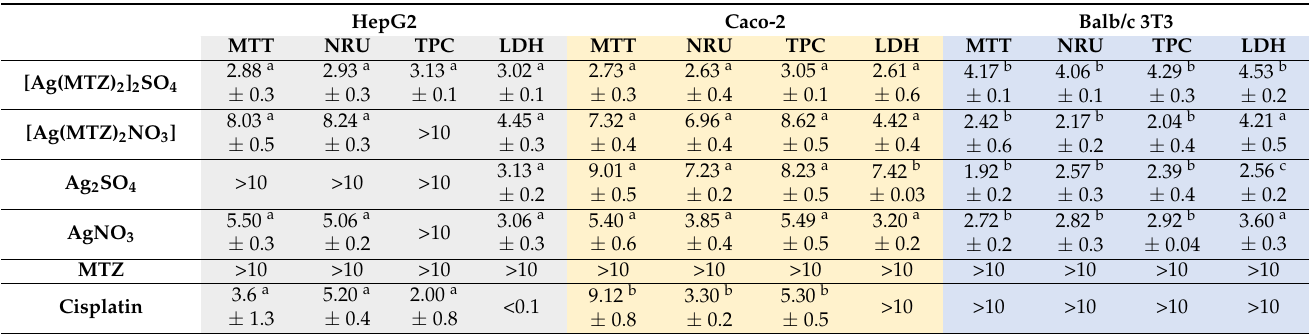
Table 3. The inhibited concentrations (IC 50 , µ M) for HepG2, Caco-2 and Balb/c 3T3 cells exposed to [Ag(MTZ) 2 ] 2 SO 4 , [Ag(MTZ) 2 NO 3 ], Ag 2 SO 4 , AgNO 3 , MTZ and cisplatin for 72 h determined by